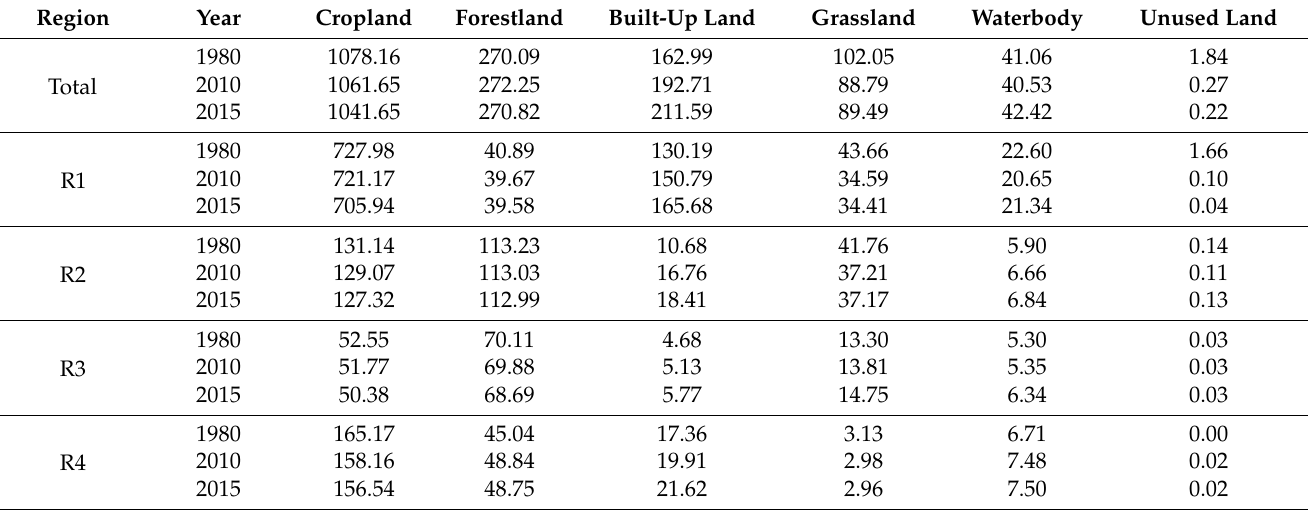
Table 3. The area of land use types in the total and ecogeographical regions in Henan Province (unit: 10 4